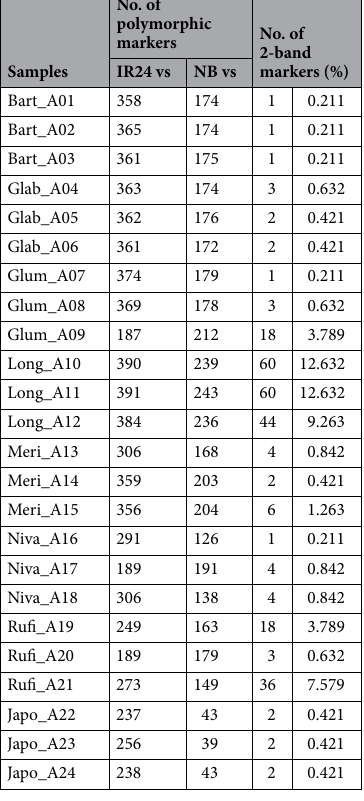
Table 2. Number of polymorhpic markers and the frequency of